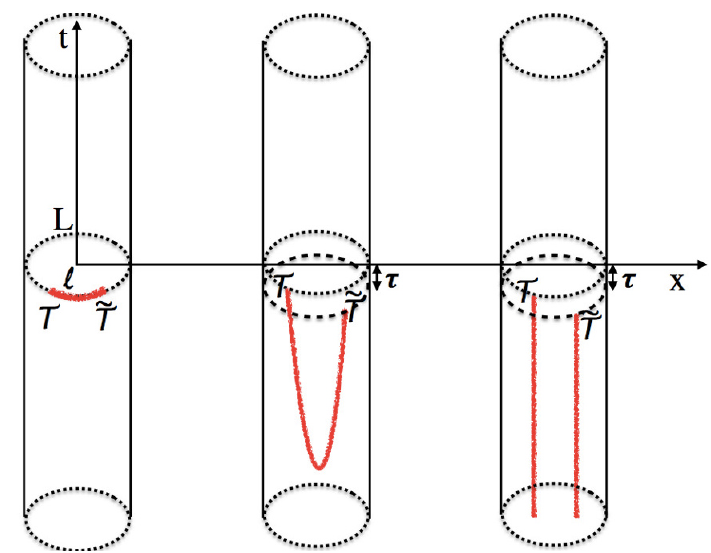
Figure 3 . Branch cut deformation along the time direction on an in(cid:12)nite cylinder of circumference L . Note that, formally, the (cid:12)elds are also slightly shifted in the time direction (hence the parameter (cid:28) ) to ensure time